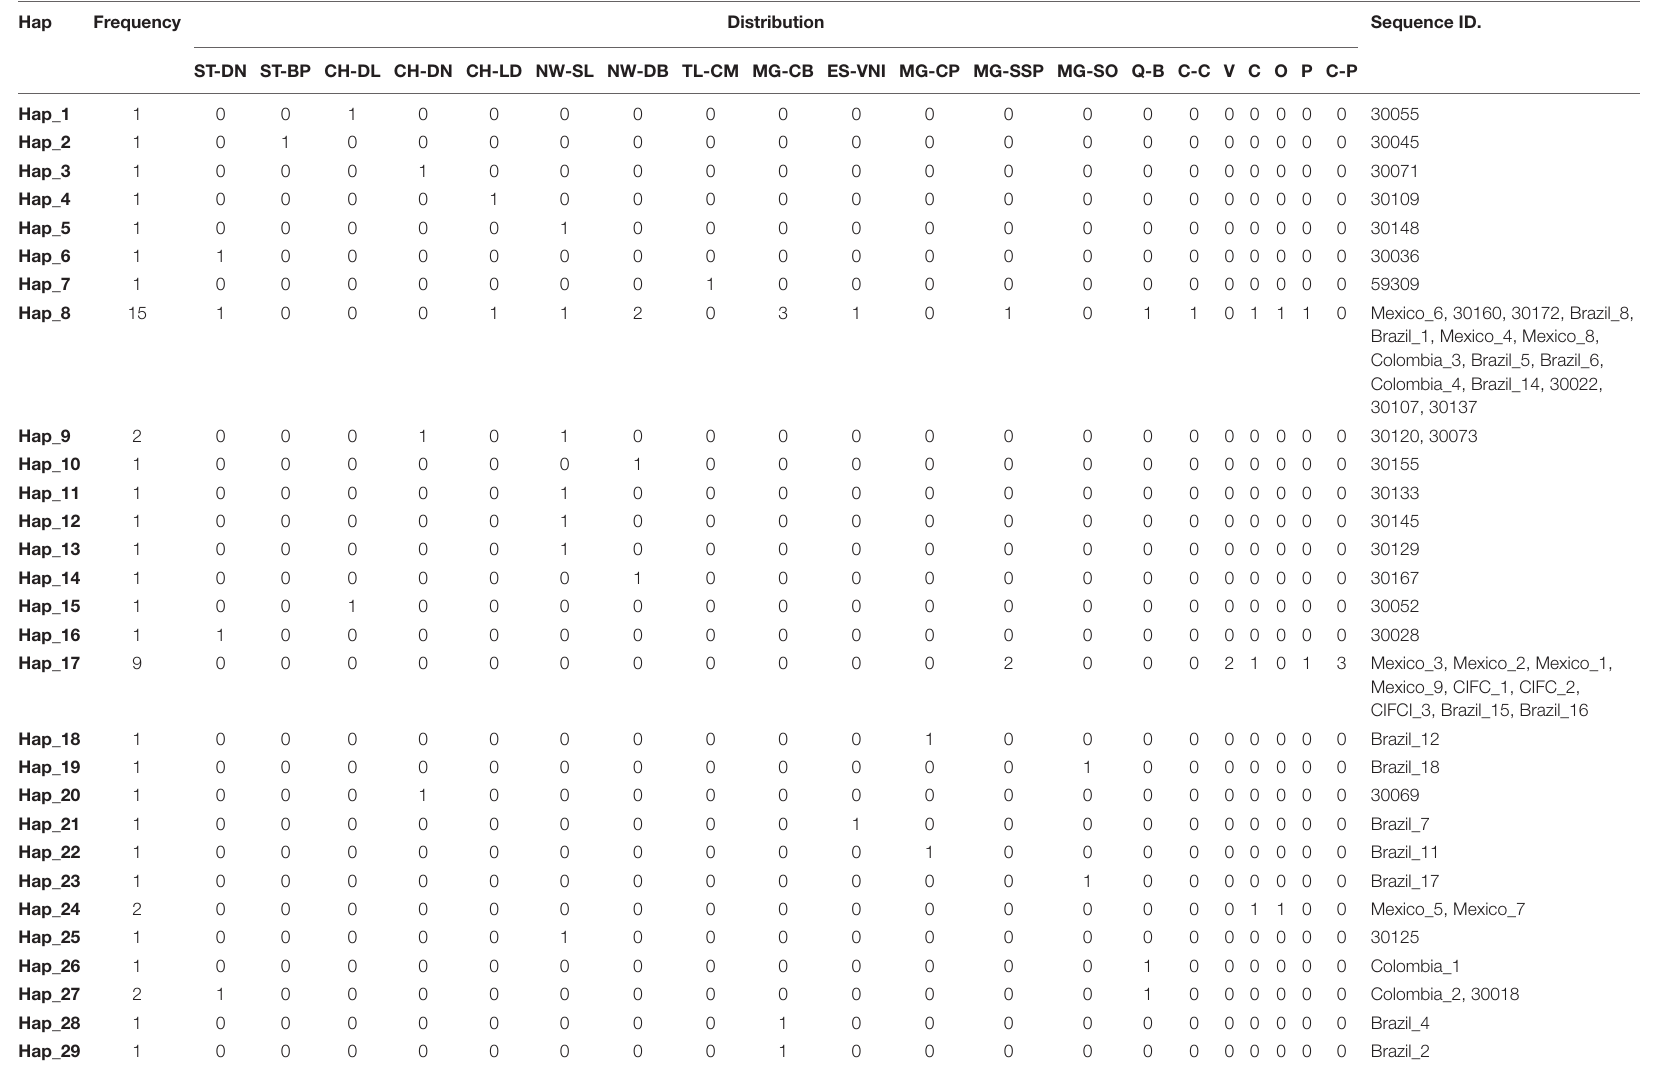
TABLE 2 | List of haplotypes obtained from sequences of coffee leaf rust fungus in Vietnam, Thailand, Portugal, and some American countries (Brazil, Colombia, Mexico). Hap Frequency Distribution Sequence